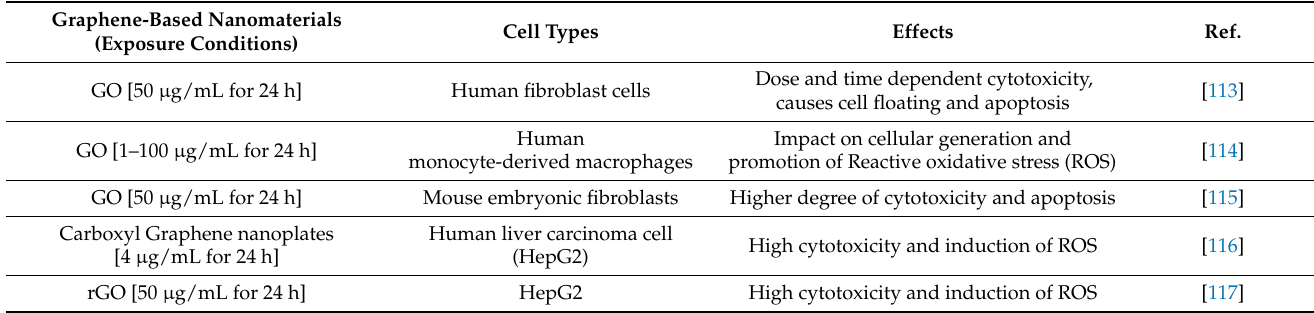
Table 1. Exposure of various cell types to graphene derivatives in different